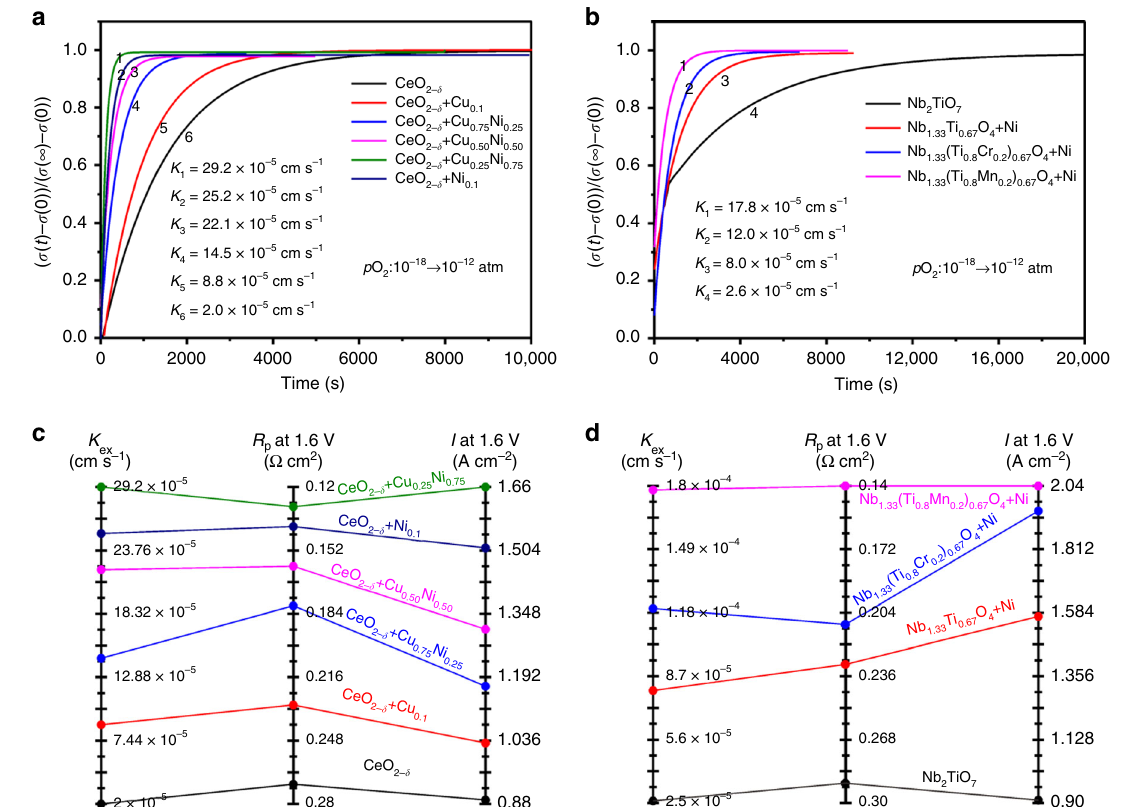
Fig. 3 Oxygen transfer at interfaces tested using electrical conductivity relaxation. a , b Normalized conductivity pro fi les of reduced Ce 0.9 (Cu 1 − x Ni x ) 0.1 O 2 − δ ( x = 0 – 0.1) and TiO 2 system (Nb 2 TiO 7 , NbTi 0.5 Ni 0.5 O 4 , NbTi 0.4 Cr 0.1 Ni 0.5 O 4 , and NbTi 0.4 Mn 0.1 Ni 0.5 O 4 ). c , d The relationship between surface exchange coef fi cient ( K ex ) and polarization resistance or current density at 1.6